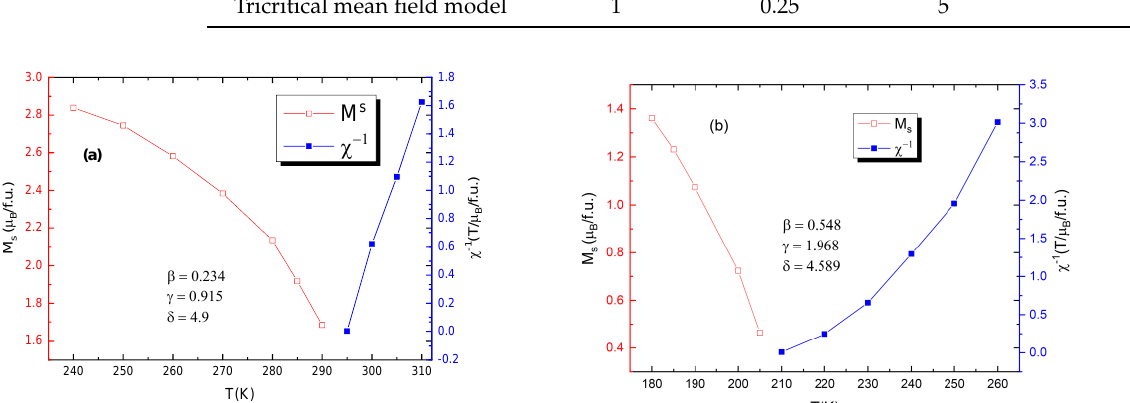
Figure 8. Modified Arrott plots for ( a ) the bulk sample with x = 0.05 and for ( b ) the nanocrystalline sample with x = 0.05.